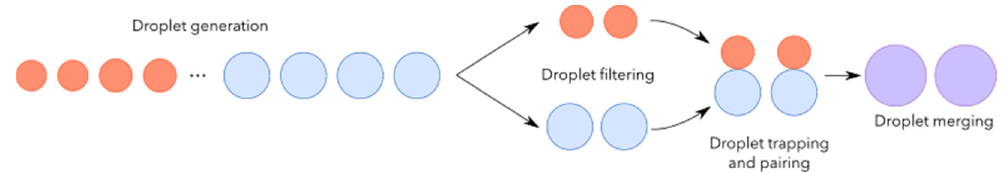
Figure 1. Droplet chip principle. The two aqueous phases are sequentially individually encapsulated in droplets from different sizes. The droplets are then filtered by size to position each droplet type towards its trapping location. The droplets are then trapped in pairs, each one containing a single droplet from each type. The droplet pairs are then merged.